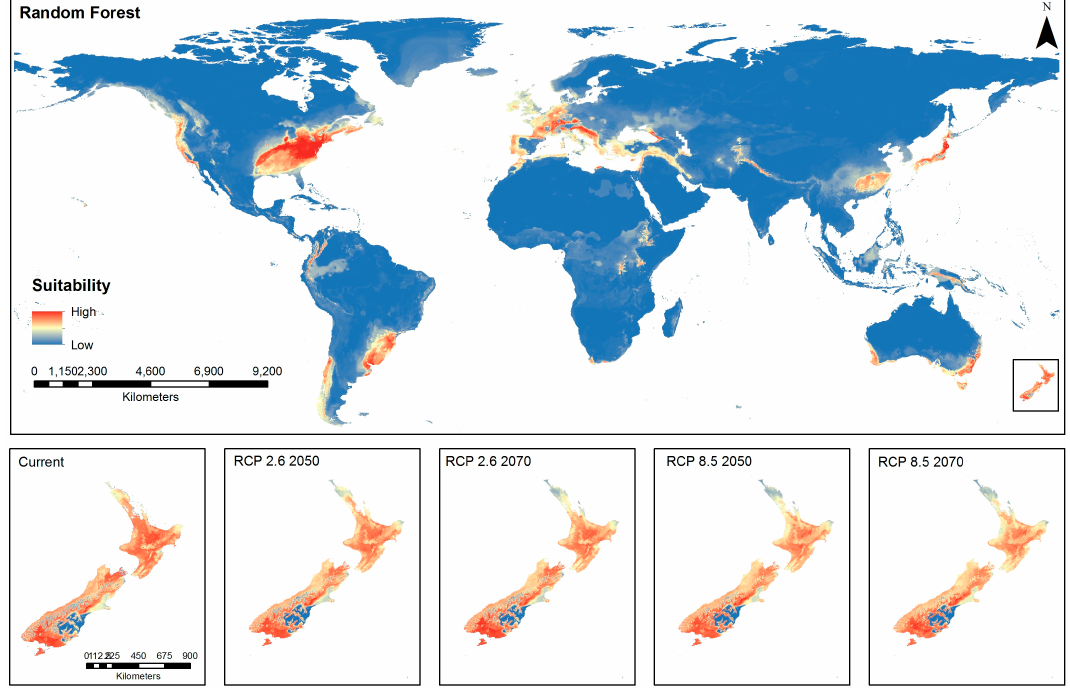
Figure 2. Global and New Zealand predictions of brown marmorated stink bug habitat suitability under current conditions and emissions trajectories of Representative Concentration Pathways (RCP) 2.6 and RCP 8.5 for the years 2050 and 2070 using Random Forest algorithm.